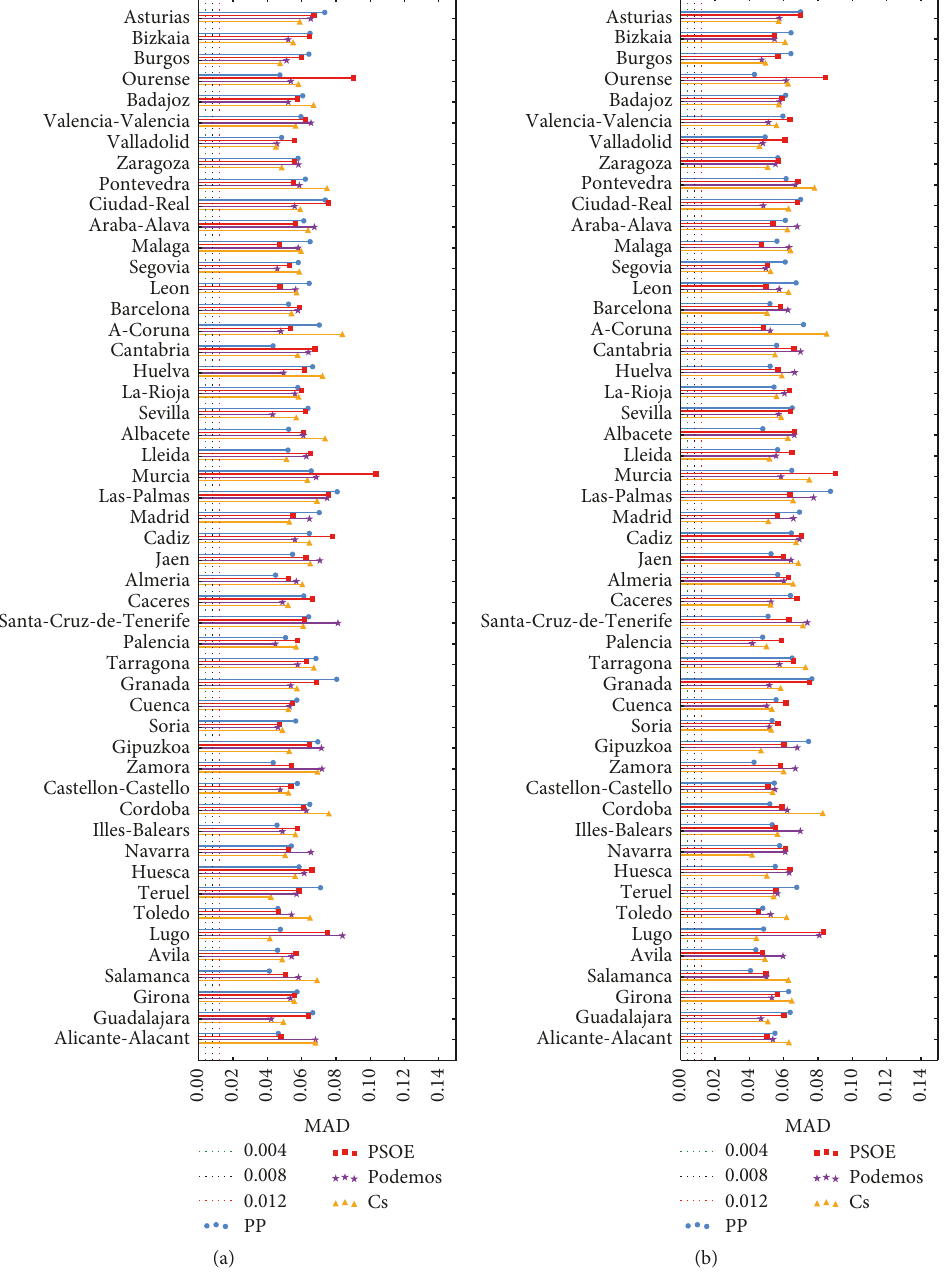
Figure 20: MAD values of the goodness of fit to 2BL for 2015 (a) and 2016 (b) at the aggregation level of precincts. In every case, the critical values for rejection at the 95 and 99% confidence level are shown. Virtually in all cases the null hypothesis is